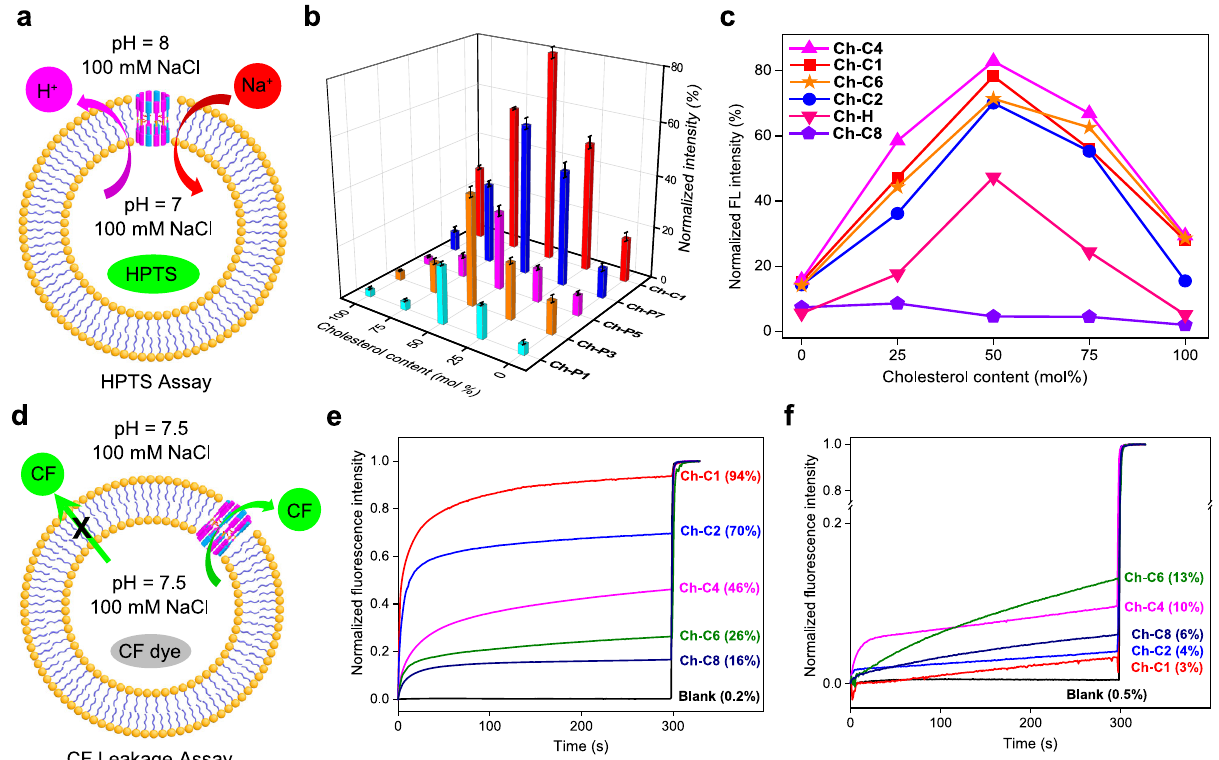
Fig. 2 | Transmembrane transport activity study of nanopores. a Schematic illustration of HPTS assay. HPTS=8-hydroxy-1,3,6-pyrenetrisulfonate. b, c Nor- malized ion transport activities of channels over a duration of 5min at 8 μ M using LUVs containing different contents of cholesterol (0, 25, 50, 75 and 100mol % relativetolipid)intheHPTSassay. d SchematicillustrationofCFdyeleakageassay forqualitativelyprobingporesizeformedbychannels Ch-C1 , Ch-C2 , Ch-C4 , Ch-C6 and Ch-C8 . CF=5(6)-carboxy fl uorescein. e and f describe changes in fl uorescence